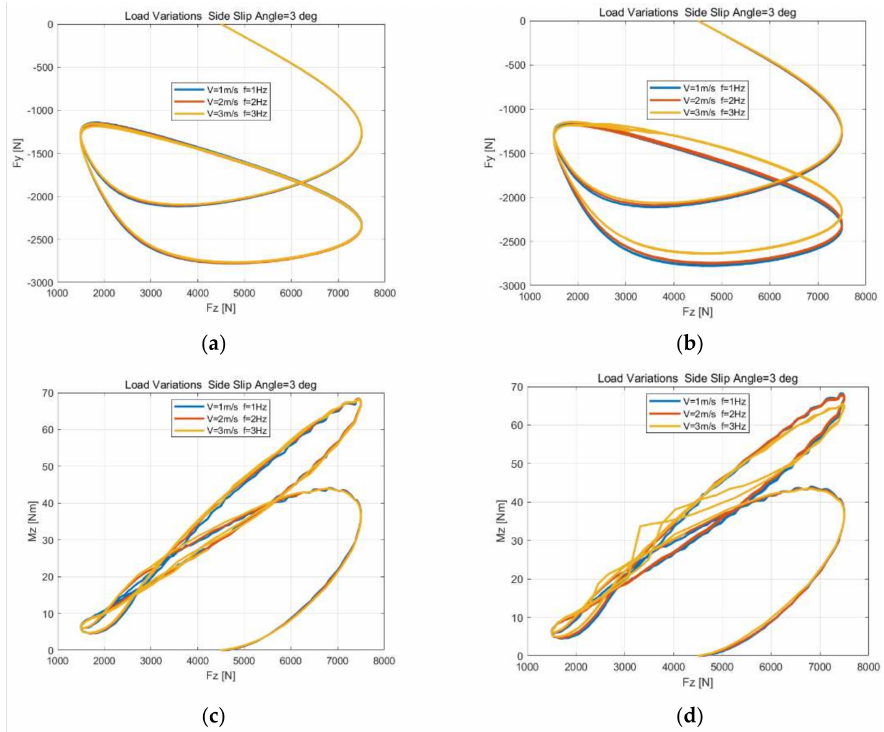
Figure 14. Response of lateral force and aligning moment under load variations at constant side slip angle input. ( a ) Response of lateral force using the proposed method. ( b ) Response of lateral force using the reference method. ( c ) Response of aligning moment using the proposed method. ( d ) Response of aligning moment using the reference